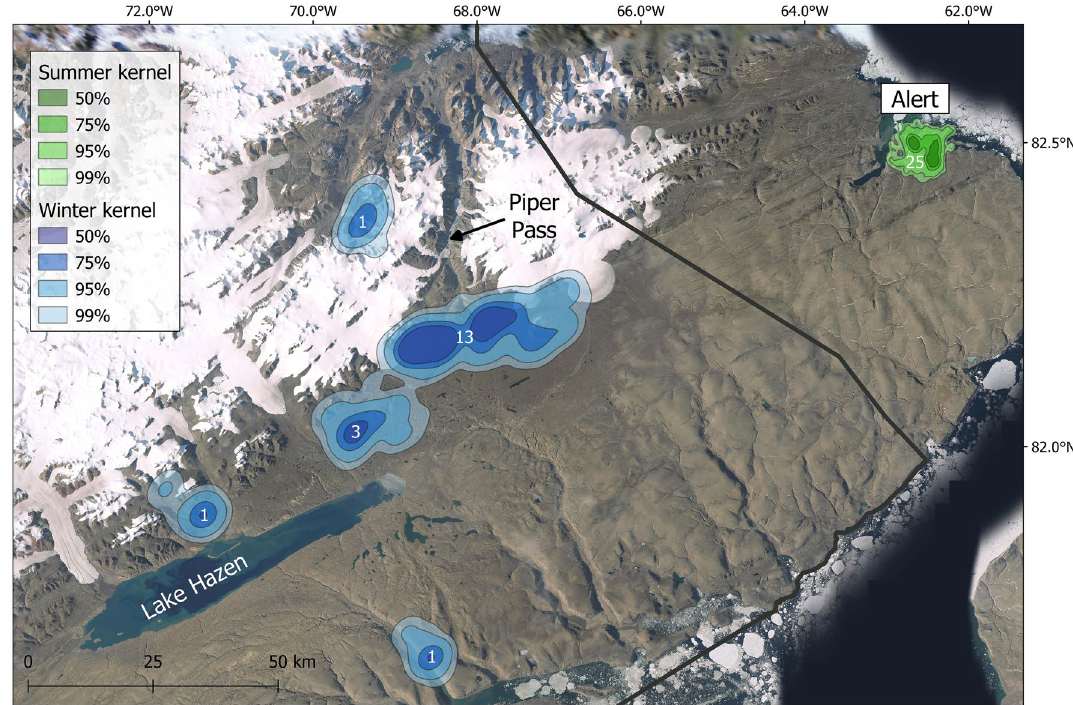
Figure 4. Kernel density distributions of Arctic hares, showing residency areas during summer (green shades, n = 25) and winter (blue shades, n = 19). Kernel density contours at the 50%, 75%, 95% and 99% levels are shown for each season. White numbers indicate the number of individuals present in the smoothed polygons of the 75% kernel density contours. The northeastern boundaries of Quttinirpaaq National Park of Canada are represented by a black line. This map was created using QGIS 3.8.3 40 . Satellite imagery was obtained from: